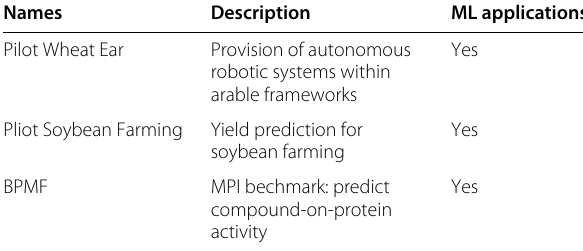
Table 3 Descriptions of the pilots and